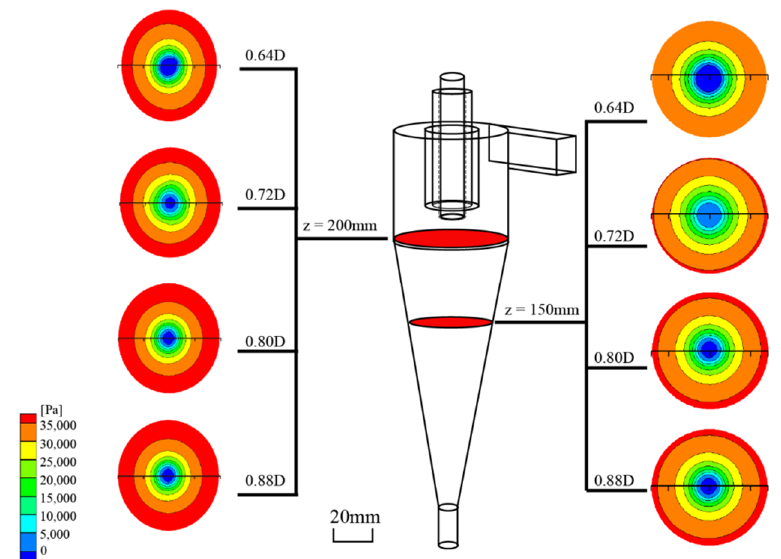
Figure 6. Influence of internal vortex-finder diameter on radial pressure.